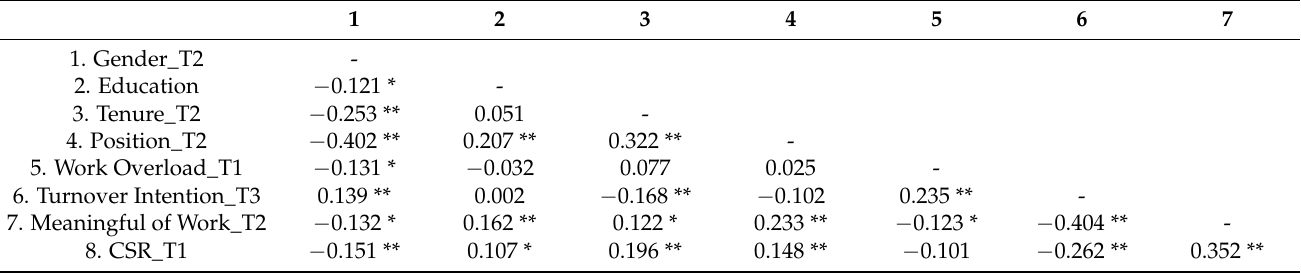
Table 2. Descriptive